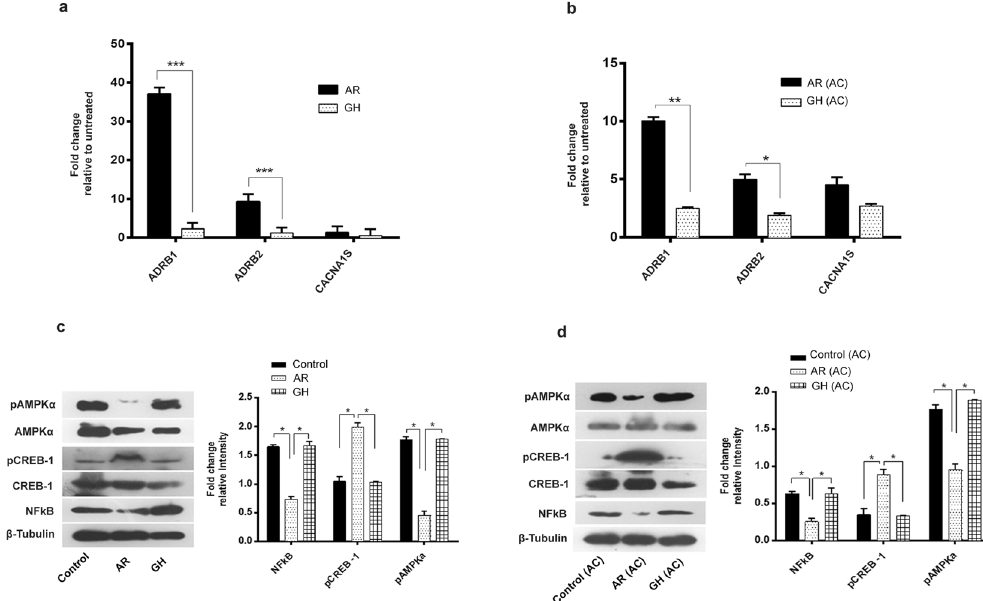
Figure 6. AR activates the ADRB1 or 2 ( β -adrenergic receptors), pCREB and inhibit pAMPK in cardiac tissues of rats, both in aging and AC groups. ( a , b ) Significant increase in mRNA expression of ADRB1/2 genes while no change in voltage dependent Ca 2 + channel (CACNA1S) in both aging and aorta constricted (AC) group of rats administered AR. ( c , d ) Representative immunoblots of pAMPK, AMPK, pCREB-1, CREB-1, NFkB and β -tubulin from rat hearts and densitometry analysis revealed increase in phosphorylation of CREB-1 and decreased phosphorylation of AMPK and down regulation in NFkB proteins were seen in AR administered rats of both aging and aorta constricted groups. β -tubulin was used as loading control. Values represent the mean ± s.e.m. of data from 4 rats in each group. * P < 0.05, ** P < 0.01, *** P < 0.001 (AR versus GH or control groups; AR (AC) versus GH (AC) or control (AC), results were analyzed by 2-way ANOVA followed by multiple comparisons with Tukey’s